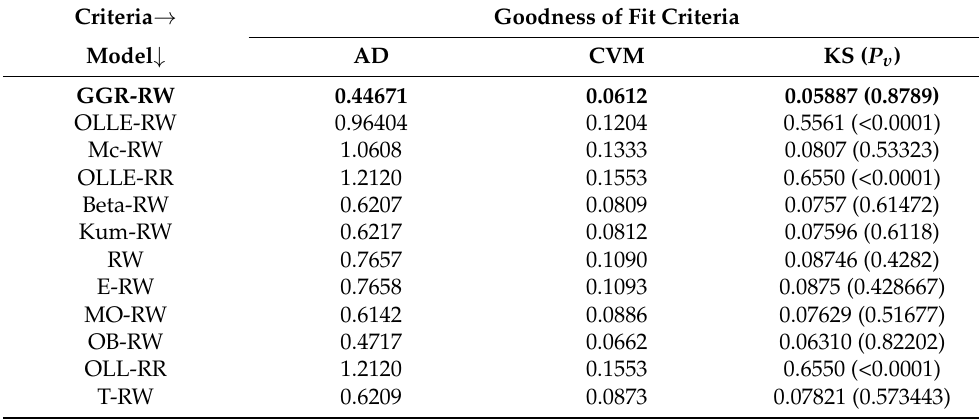
Figure 3. P-P panel (left) and estimated HRF (right) for the breaking stress of carbon fiber data. Table 2. CVM, AD, KS, and P υ for the breaking stress of carbon fibers data. Criteria → Goodness of Fit